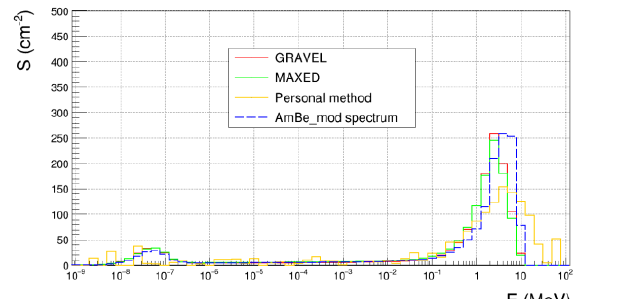
Fig. 9. Unfolding results (cm -2 ), as function of energy (MeV), with a moderated 252 Cf guess spectrum and low statistics (Φ = 1.41×10 3 cm -2 ) . On this figure, a moderated Am/Be source .